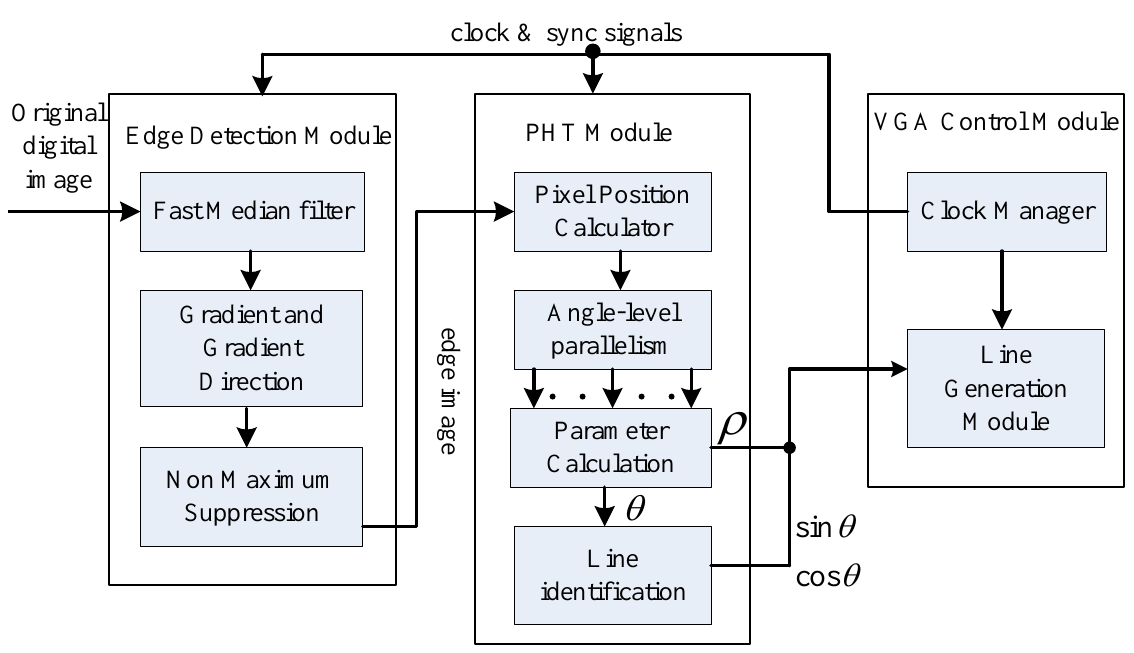
Figure 12. Integral PHT algorithm